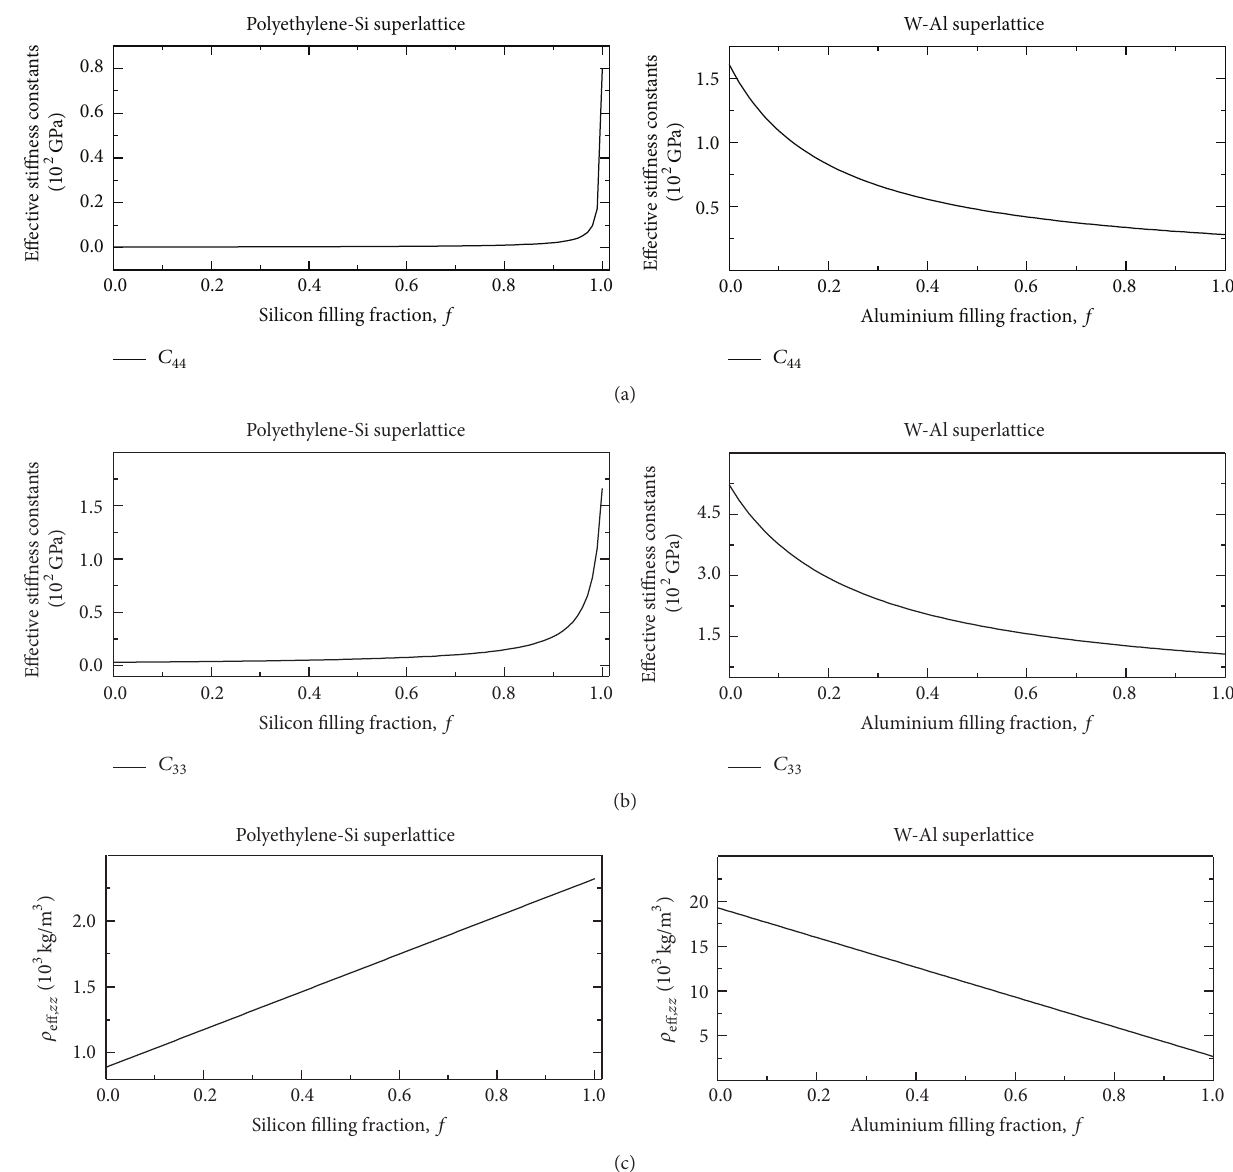
Figure 7: Graphs of the effective mass density 𝜌 eff ,𝑧𝑧 (c) and the effective stiffness constants 𝐶 eff ,44 (a) and 𝐶 eff ,33 (b) of Polyethylene-Si and W-Al